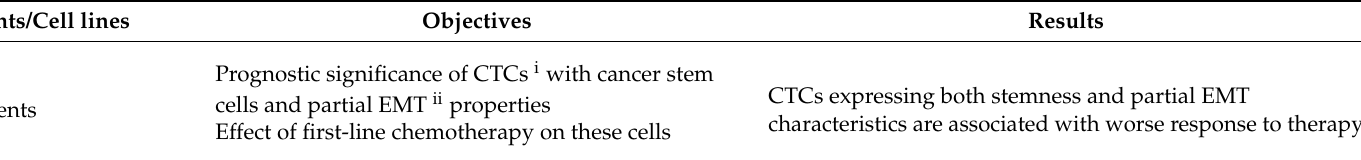
Table 2. Summary of studies investigating the role of CTCs i in chemoresistance in MBC iii